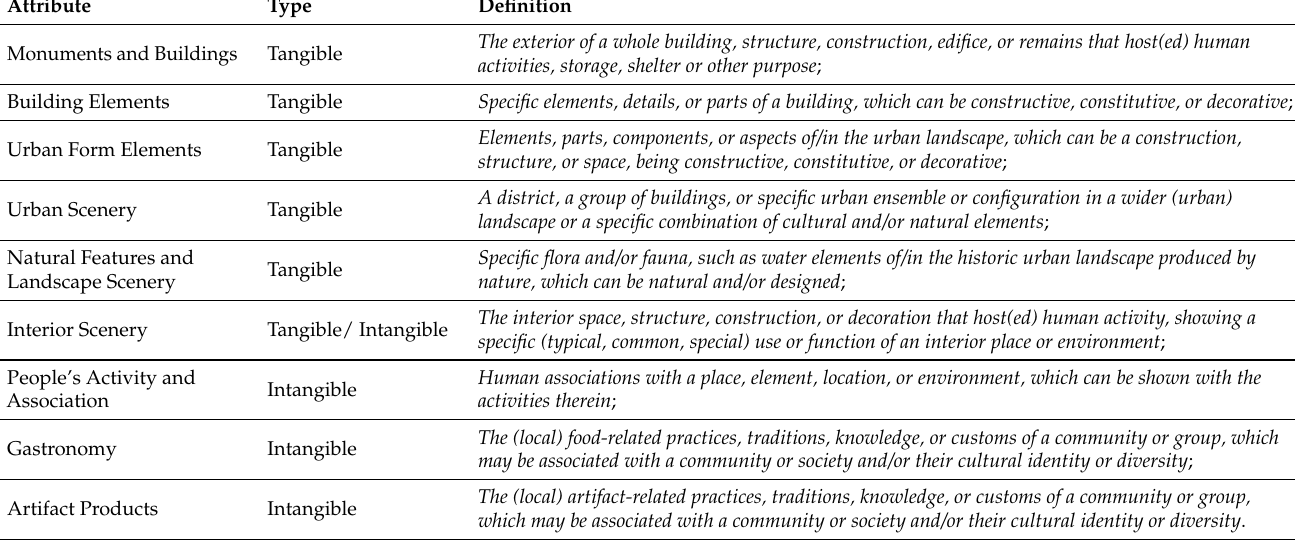
Table A4. The definition for depicted scenery as heritage attribute category in this dataset and its tangible/intangible type according to previous scholars [5,26,93].